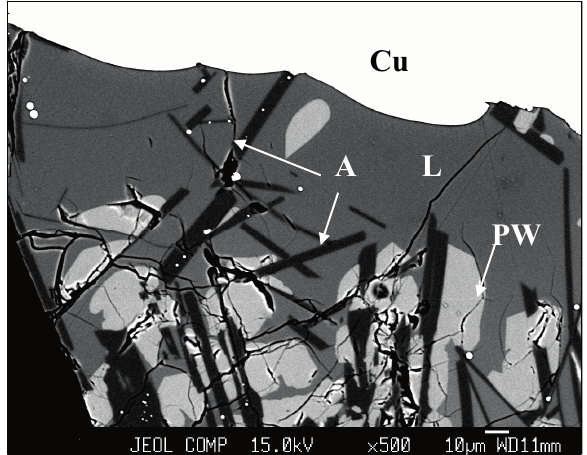
Figure 3. Typical microstructure of quenched CaO-SiO 2 - Al 2 O 3 samples equilibrated with metallic copper. Compo- sition of liquid phase was used for temperature determina- tion. Legend: Cu-metallic copper, L-former liquid phase, A-anorthite,